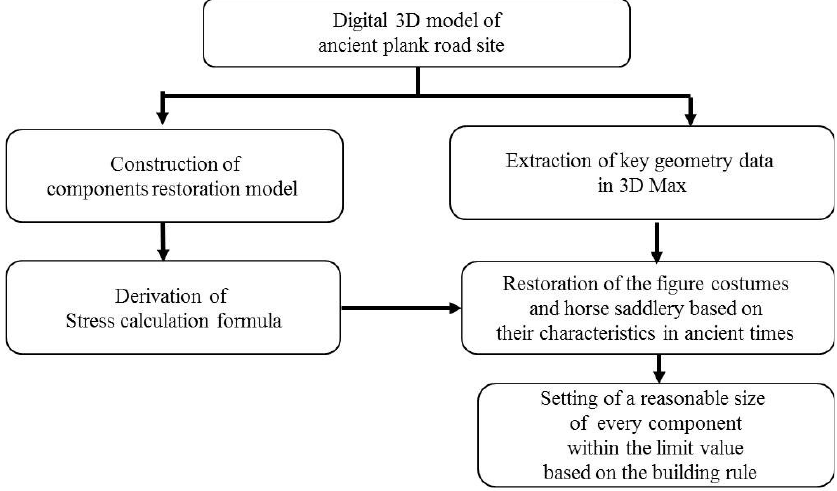
Figure 6. Preparing a process for model analysis and a restoration program of the ancient plank road